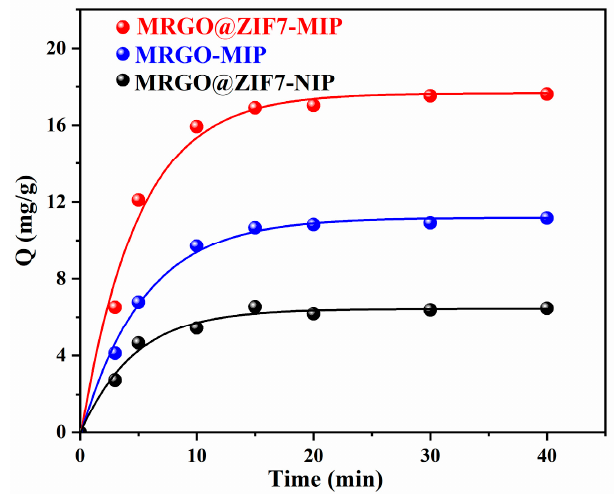
Figure 6. Adsorption kinetic curve of MRGO@ZIF7-MIP, MRGO-MIP, and MRGO@ZIF7-NIP for BPA. Other conditions: 20 mg sorbent, 20 mL sample solution of 0.08 mmol L − 1 BPA, temperature 25 °C.